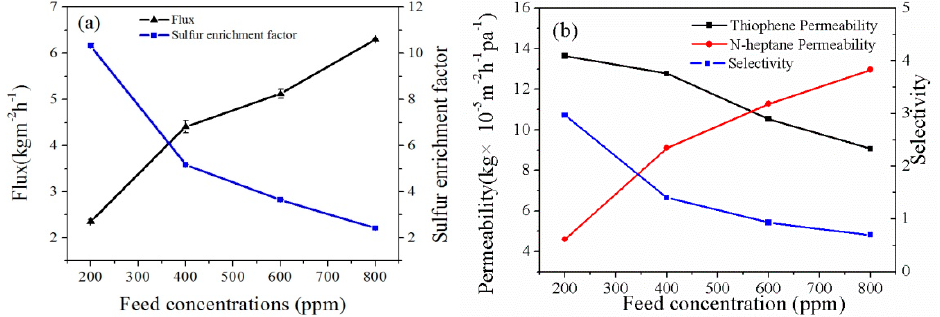
Figure 10. The effect of feed sulfur content on ( a ) total flux and sulfur enrichment factor; ( b ) permeability and selectivity of the CuBTC-filled PEG MMMs.